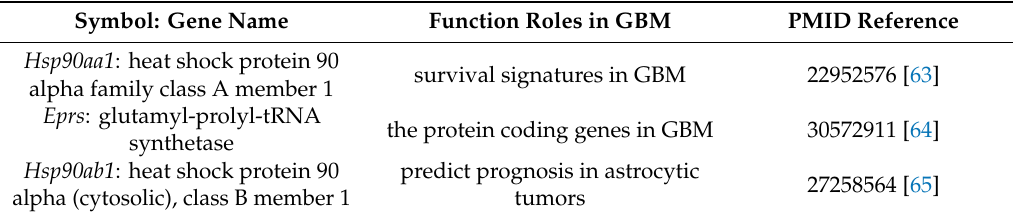
Table 5. The biological functions, corresponding PubMed IDs and literatures for genes with large topological changes between NPC and astrocytes